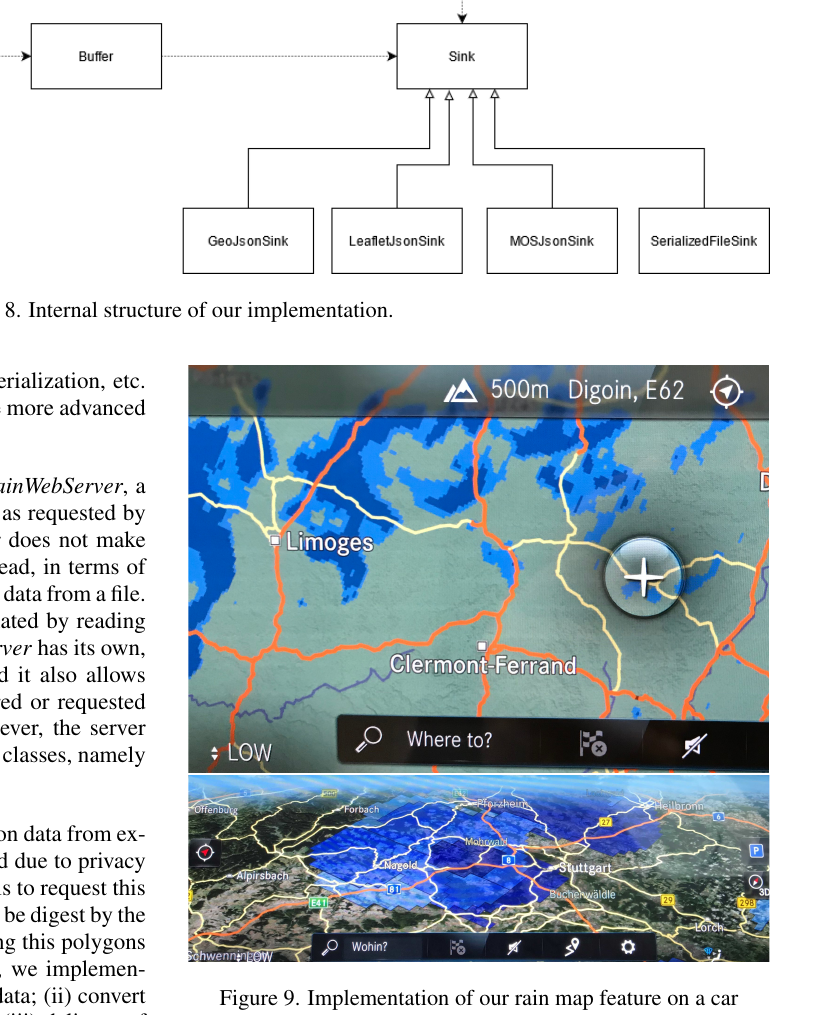
Figure 9. Implementation of our rain map feature on a car navigation system: (top) 2D and (bottom) 3D